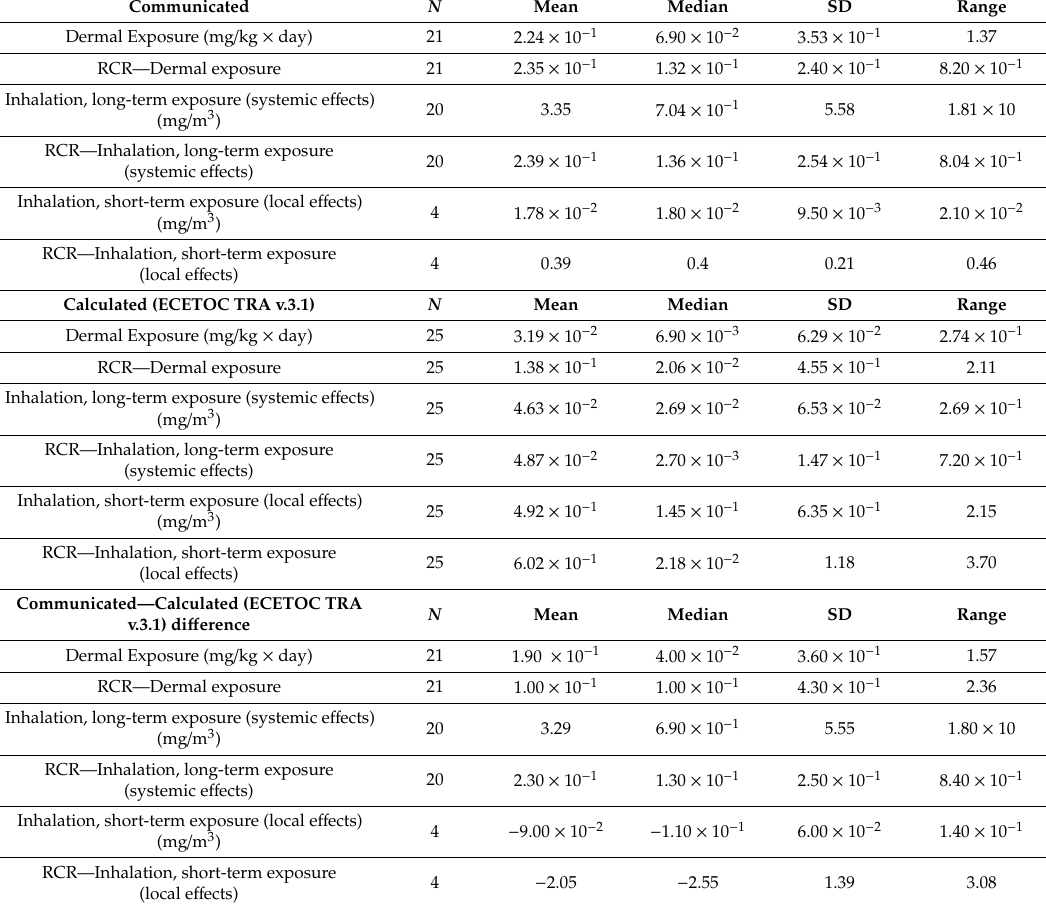
Table 9. Comparison and di ff erence between communicated exposure estimates and calculated exposure estimates with ECETOC TRA v.3.1 with associated RCRs. N: number of valid exposure estimates. SD: standard